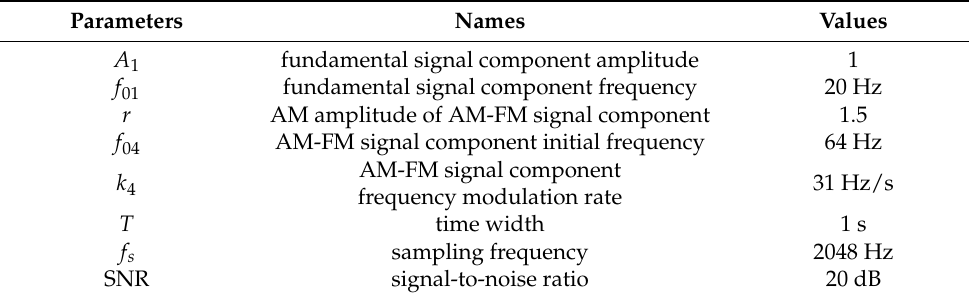
Table 6. Parameters of the rotor unbalance vibration fault